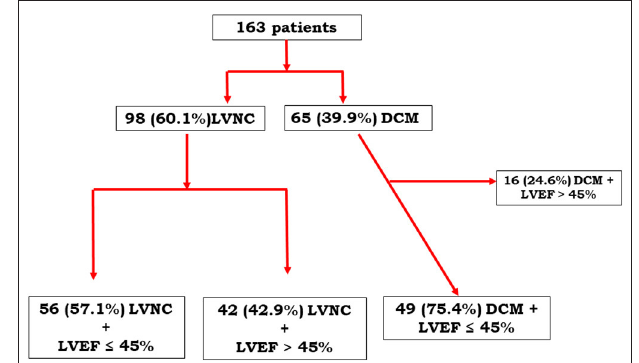
FIGURE 1 | Flow chart.